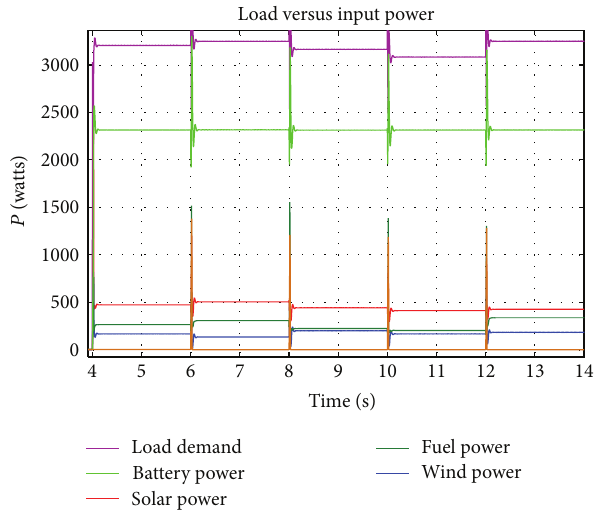
Figure 25: Controller discharges the battery with the peak discharg- ing limit, and as the LD is still higher the controller duly discharges the fuel cell along with the PV and WTG to supply the fixed LD.